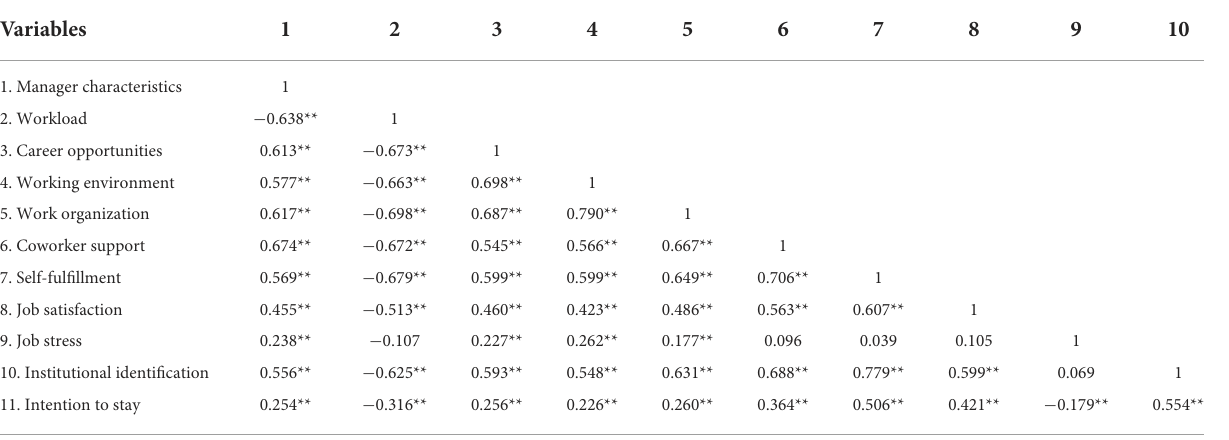
TABLE 5 Correlation of the continuous variables.